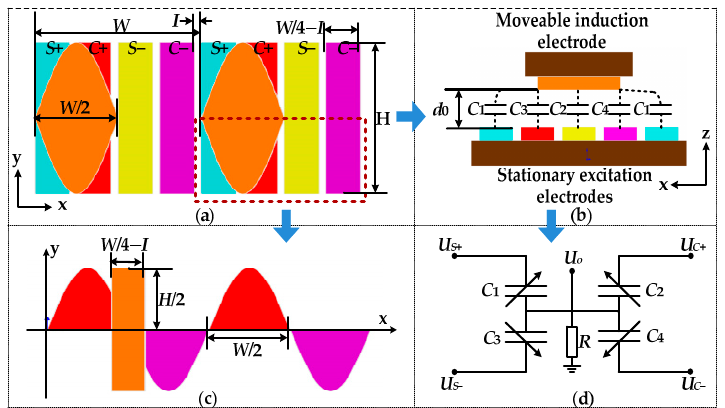
Figure 1. Schematic diagrams of a single-row capacitive displacement sensing structure and its measurement principle. Top view ( a ) and side view ( b ) schematic diagrams of the single-row sensing structure. ( c ) Schematic diagram presents a geometric representation of the effective area variation of the selected region in (a). ( d ) Equivalent capacitor circuit based on (b).